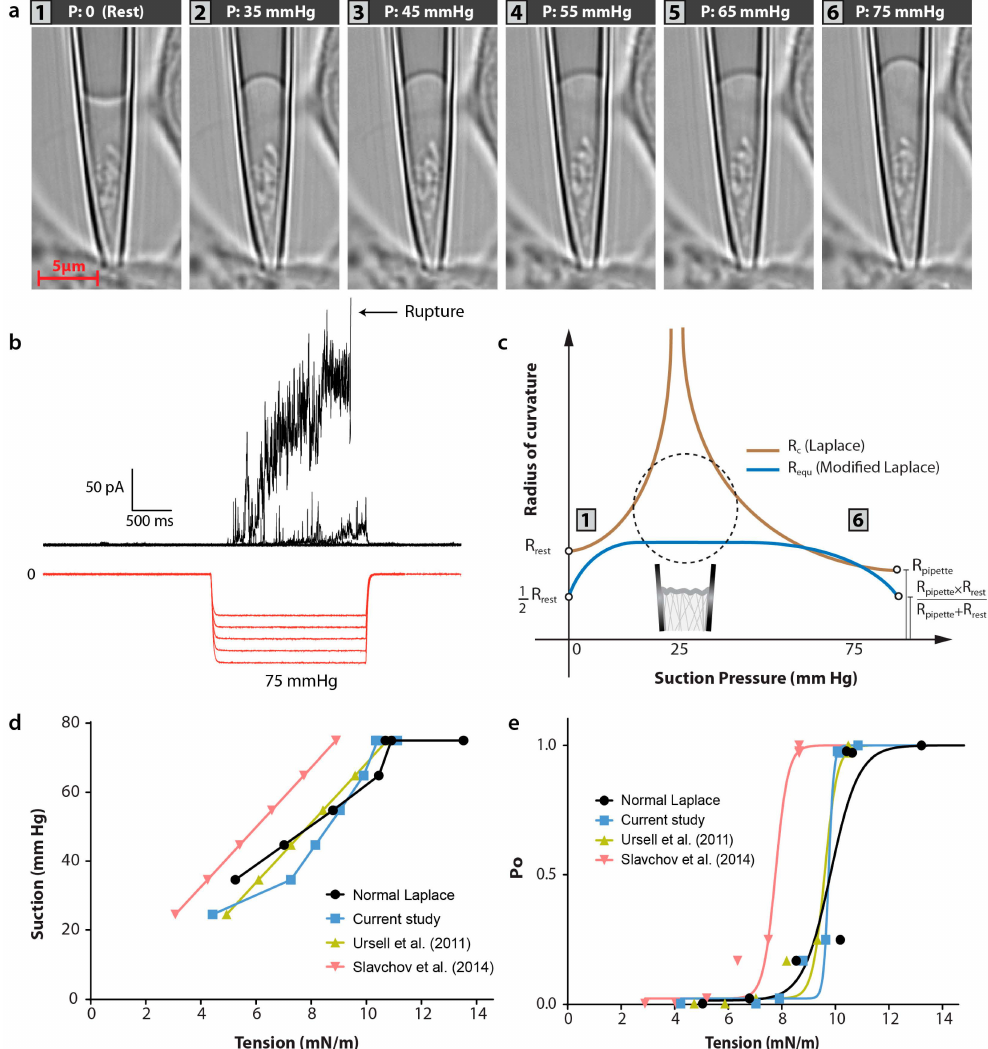
Figure 6. High-resolution images of a cell-attached patch containing G22S-MscL-cGFP channels and corresponding current activated during steps of negative pressure. ( a ) Images of a cell-attached membrane patch from a HEK293T cell; ( b ) Activation of G22S-MscL-cGFP channels by increasing 2s pressure steps from ´ 25 to ´ 75 mmHg ( ∆ V patch = +5 mV); ( c ) Comparison between radius of curvature, R c , of Laplace equation and equivalent radius of curvature, R equ , used in our modified Laplace’s equation. This R equ is more adequate for estimating the tension distribution in semi-flat states of the membrane patch as well as other patch clamping situations; ( d ) Calculation of stress induced by suction in all 6 stages of patch clamping using different techniques [42,43] ( e ). Open probability of G22S-MscL-cGFP channels from record ( b ) plotted against the tension calculated using different methods